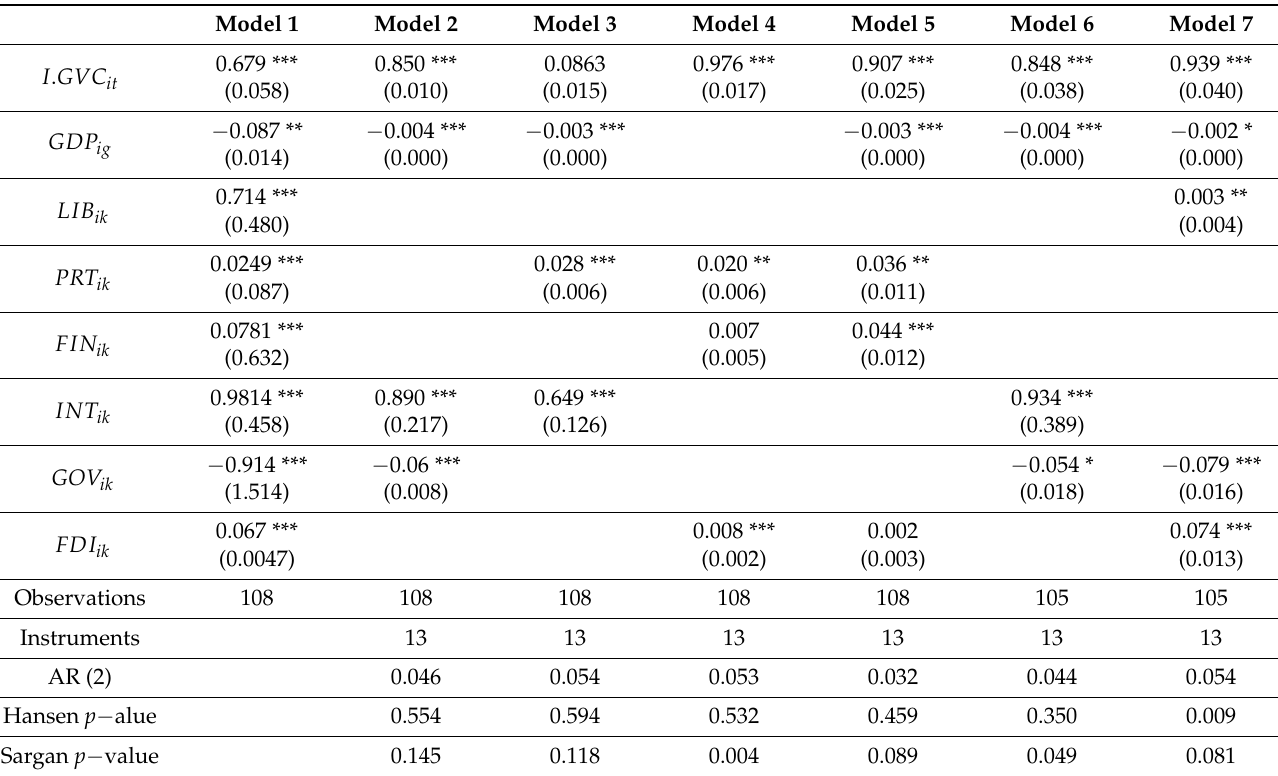
Table 3. System GMM